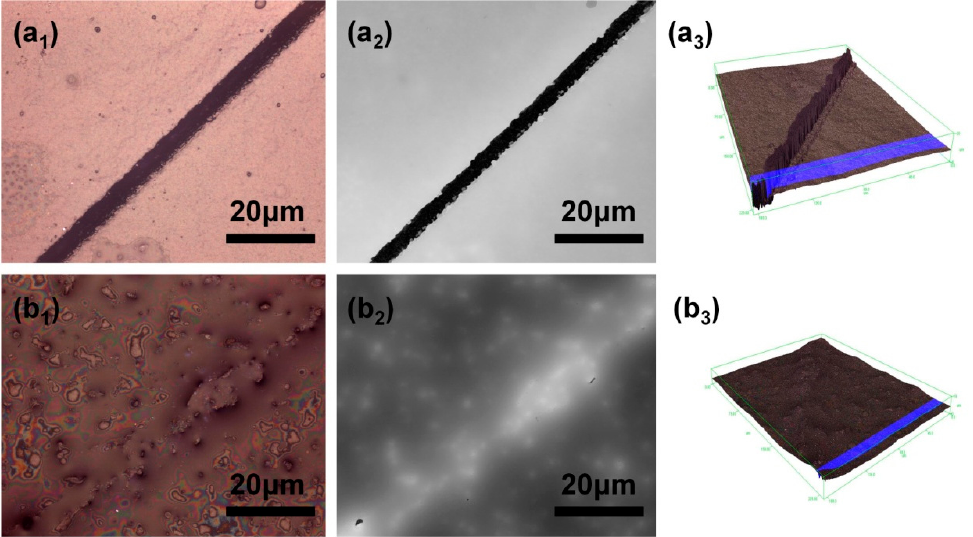
Figure 12. TCCM images of scratched regions ( a 1 – a 3 ) control coating without self-healing microcapsules; ( b 1 – b 3 ) self-healing coating containing self-healing microcapsules.